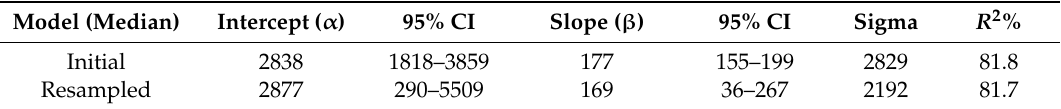
Table 2. Litter decomposition table showing the intercept, slope, and corresponding 95% confidence intervals for each, the initial model (fitted to the raw data) and the median of model fits to resampled data points; goodness of fit is indicated by the R 2